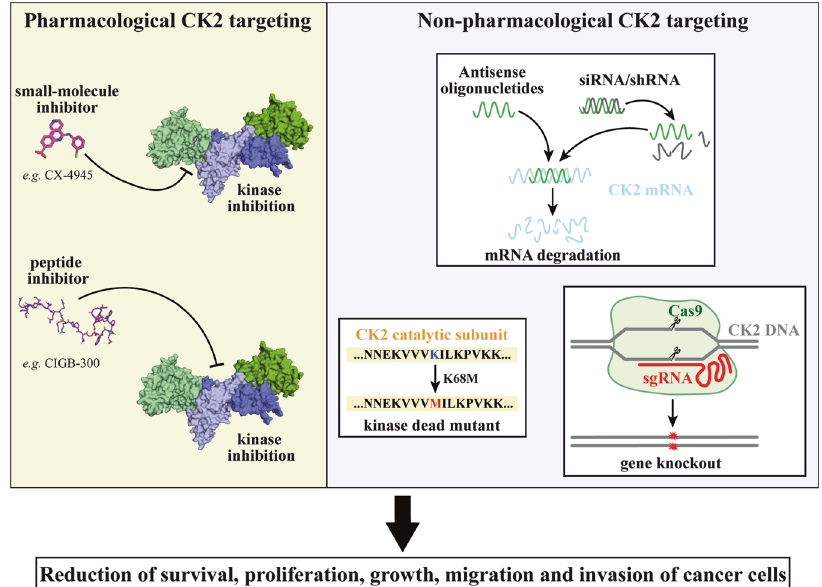
Fig. 1 Pharmacological and non-pharmacological approaches that have been used to target CK2 in cancer cells. The left side shows the major pharmacological targeting strategies, represented by ATP-competitive small molecule inhibitors (as the clinical-grade inhibitor CX-4945, upper) or peptide-based inhibitors (as the clinical-grade compound CIGB-300, bottom). The right side schematically shows the most common non-pharmacological approaches to target CK2: the mRNA downregulation by antisense oligonucleotides or shRNA/siRNA (upper), the expression of kinase-dead mutants (bottom, left), and the gene knockout by CRISPR/Cas9 technology (bottom, right). All strategies reduce the survival and attenuate the oncological features of cancer